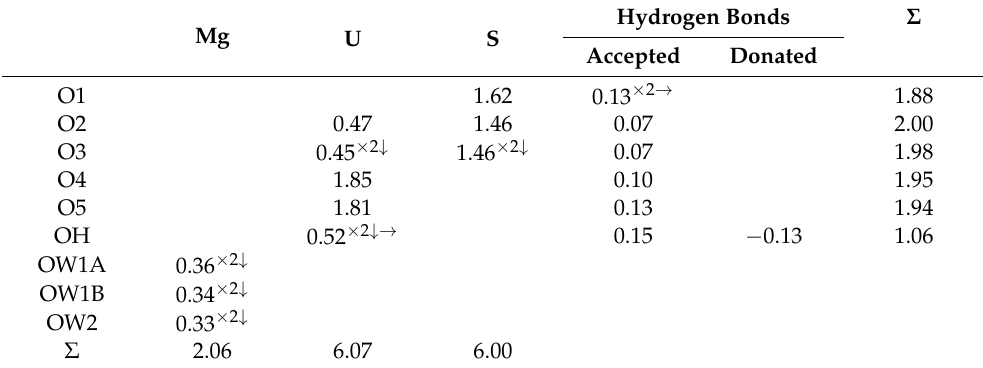
Table 6. Bond-valence analysis for chenowethite. Values are expressed in valence units *. Hydrogen Bonds Σ Mg U S